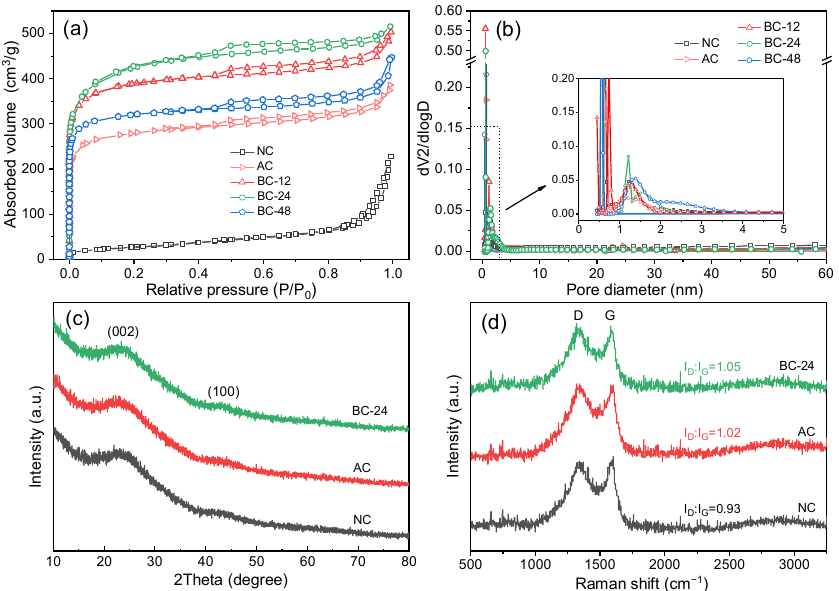
Figure 2. ( a ) N 2 adsorption-desorption isotherms, ( b ) pore size distribution curves, ( c ) XRD patterns, and ( d ) Raman spectra of the indicated biochar samples. cm 3 /g), demonstrating its good application potential. Table 1. Porosity analysis of NC, AC, and BC- x .